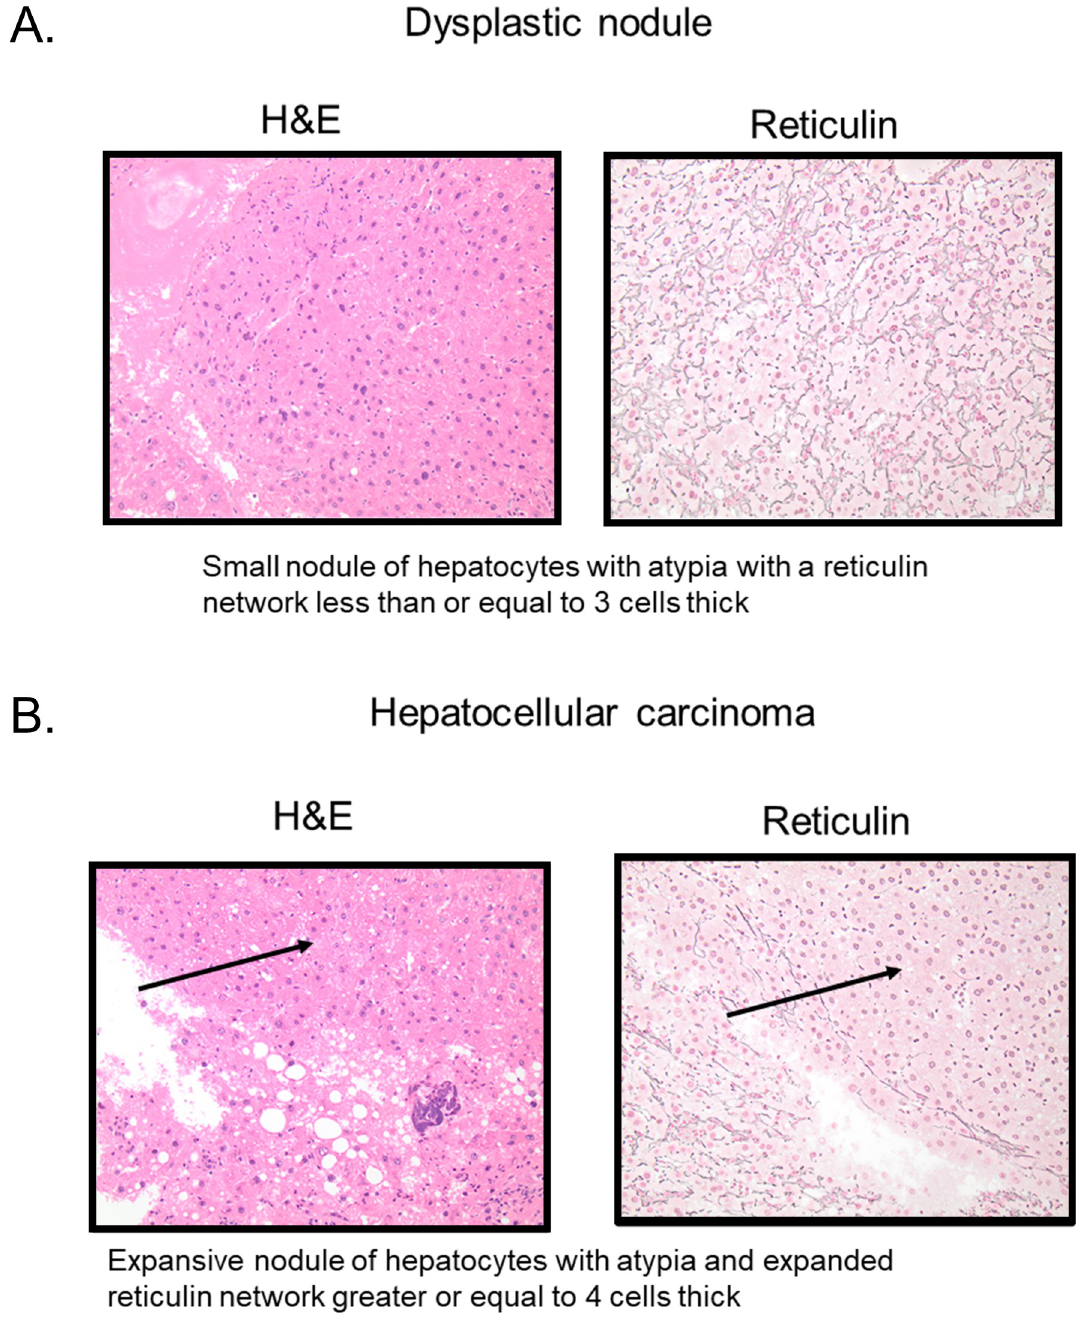
Fig 6. Histological pictures showing representative images of dysplastic nodules and HCC. (A) Micrographs representing dysplastic nodules. (B) Micrographs of hepatocellular